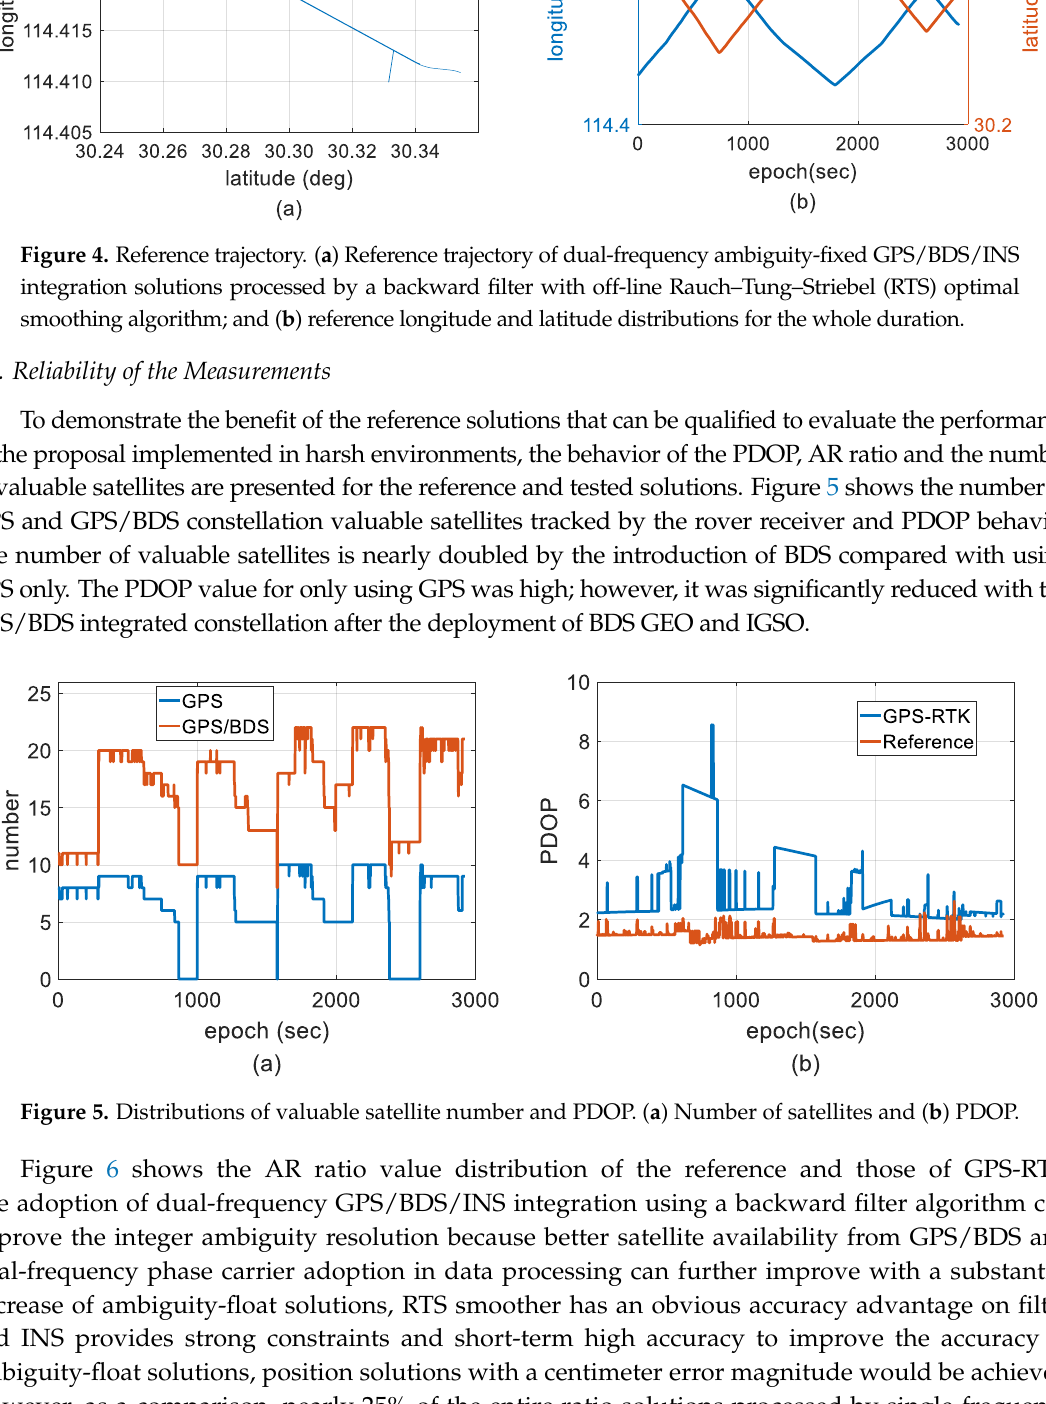
Figure 5. Distributions of valuable satellite number and PDOP. ( a ) Number of satellites and ( b ) PDOP.